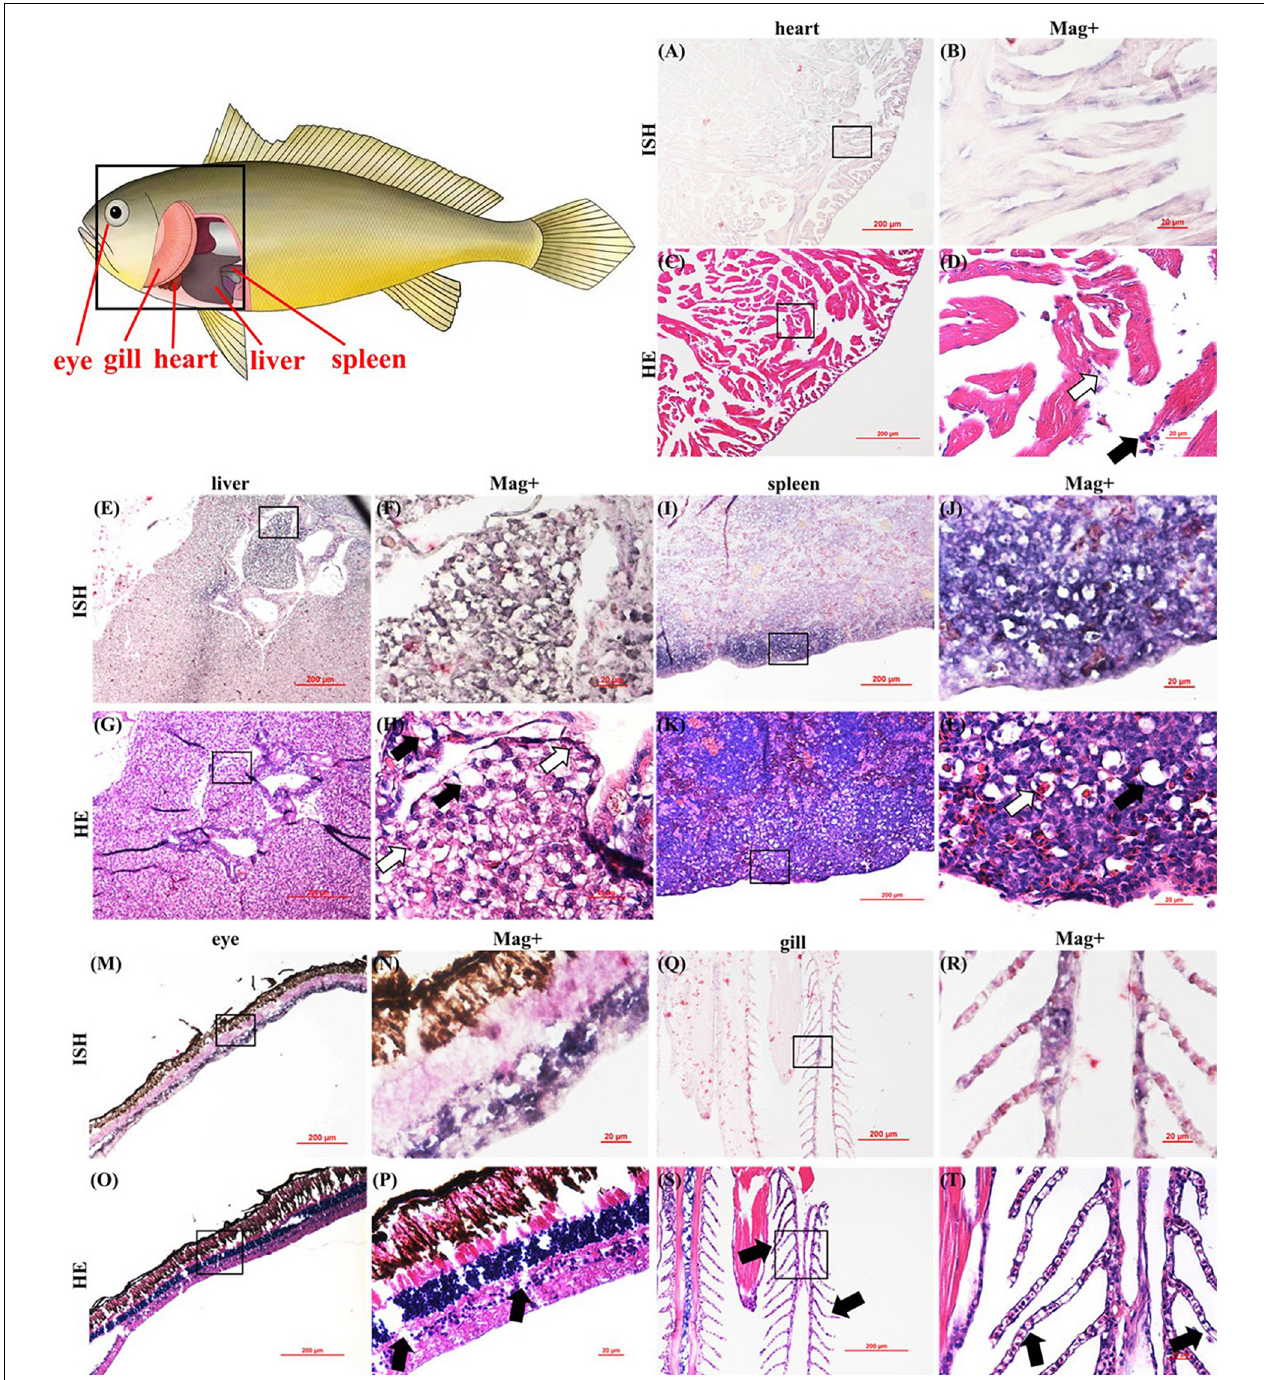
FIGURE 2 | Pattern diagram of Larimichthys crocea and micrographs of in situ hybridization (ISH) and HE staining for heart, liver, spleen, eye, and gill of the L. crocea naturally infected with CMNV. (A) Micrograph of ISH for the heart. (B) Magnified micrograph of the cardiac muscle in the black frame in (A) . Note the purple signals of CMNV probe in the necrotic cardiac muscle. (C) Micrographs of HE staining for the heart. (D) Magnified micrograph of the cardiac muscle in the black frame in (C) . Note the dissolved necrosis (pointed by white arrows) and mild hemocyte infiltration in the fibromuscular stroma (pointed by black arrows) of the cardiac muscle. (E) Micrograph of ISH for the liver of the L. crocea . (F) Magnified micrograph of the zone in the black frame in (E) . (G) Micrographs of HE staining for the liver. (H) Magnified micrograph of the zone in the black frame in (G) . Note the serious vacuolation (pointed by black arrows) and karyopyknosis (pointed by white arrows) of the hepatocytes. An intense CMNV probe hybridization signal could be observed at necrotic hepatocytes. (I) Micrographs of ISH for spleen. (J) Magnified micrograph of the zone in the black frame in (I) . (K) Micrographs of HE staining for spleen. (L) Magnified micrograph of the zone in the black frame in (K) . Note